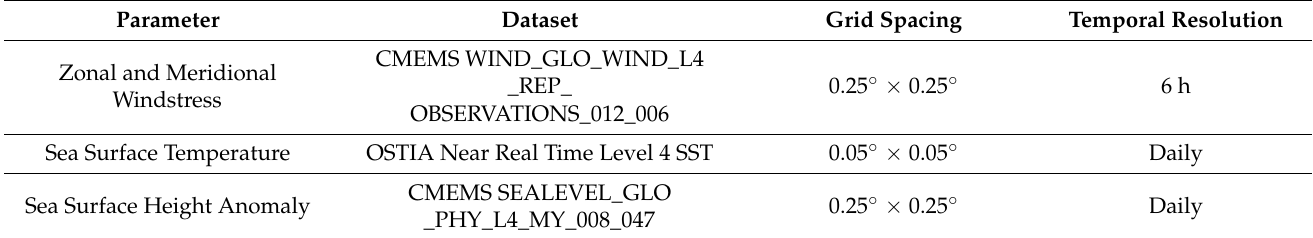
Table 1. Details of datasets used. Parameter Dataset Grid Spacing Temporal Resolution Zonal and